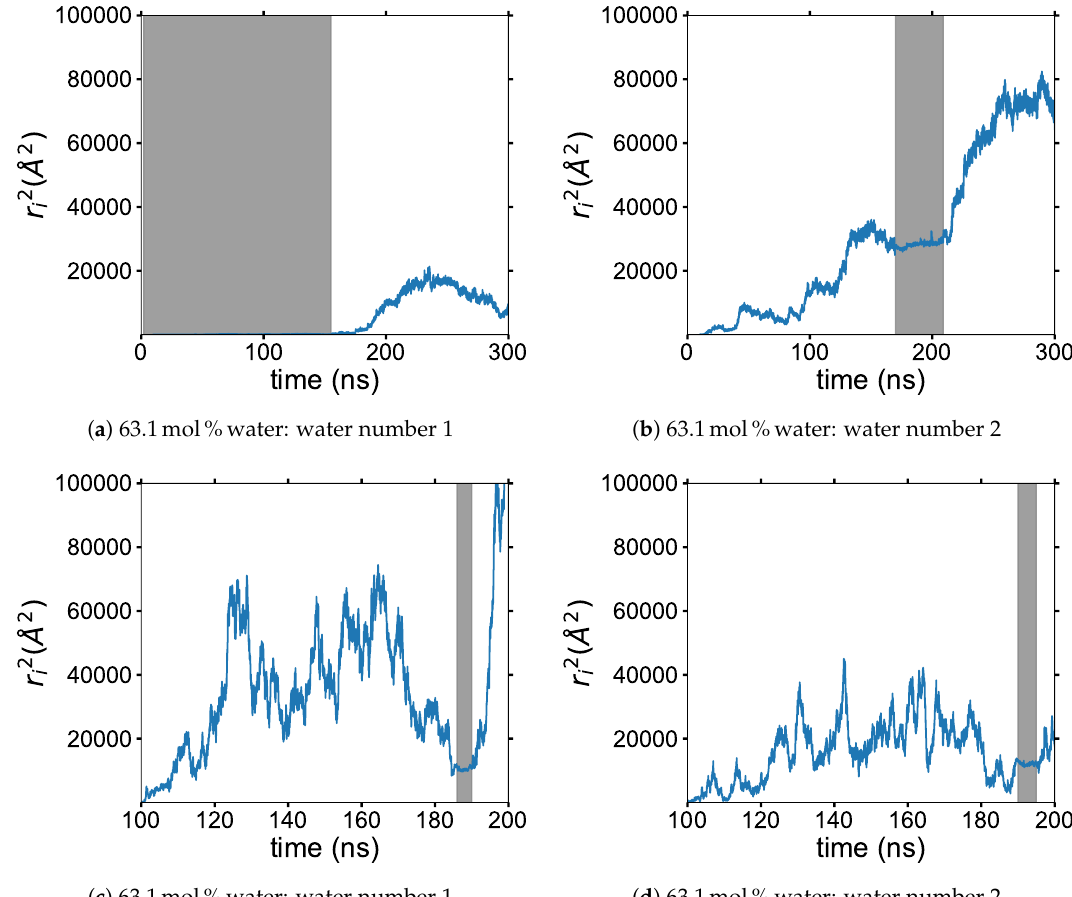
Figure A21. Water diffusion in and out of the pocket between the cellulose strands: ( a ) water number 1 at the 63.1mol%water concentration; ( b ) water number 2 at the 63.1mol%water concentration; ( c ) water number 1 at the 91.1mol%water concentration; and ( d ) water number 2 at the 91.1mol%water concentration. LAMMPS was utilized to calculate the squared displacement ( r i2 ) of individual water molecules using the oxygen atom as the center of mass [22]. The gray shaded area indicates when the water molecule is in the pocket between the cellulose strands. The lack of variation, increase, or decrease in the squared displacement of the water molecule in the gray shaded area shows that the water molecule’s mobility can be decreased when it is in the water pocket (i.e., water’s diffusion can be decreased when the water molecules are between the cellulose strands). The water molecules show some diffusion in the gray shaded areas, some of which are attributed to the cellulose bundles movement, the water moving with the peeling cellulose strand, or the water moving in the pocket between the cellulose